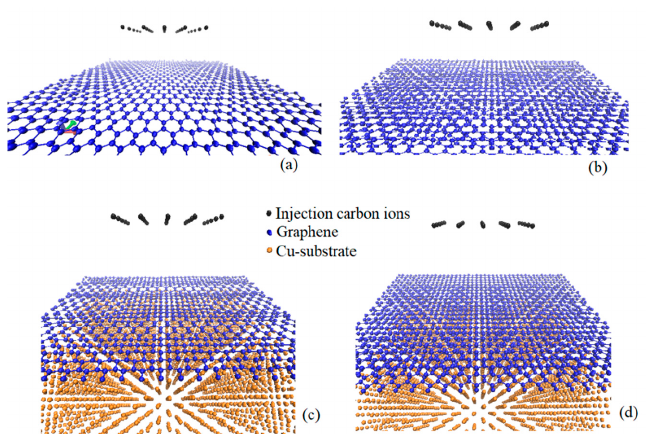
Figure 1. Atomic configuration of graphene: ( a ) single-layer graphene; ( b ) bi-layer graphene; ( c ) single-layer graphene on copper substrate; and ( d ) bi-layer graphene on copper substrate.